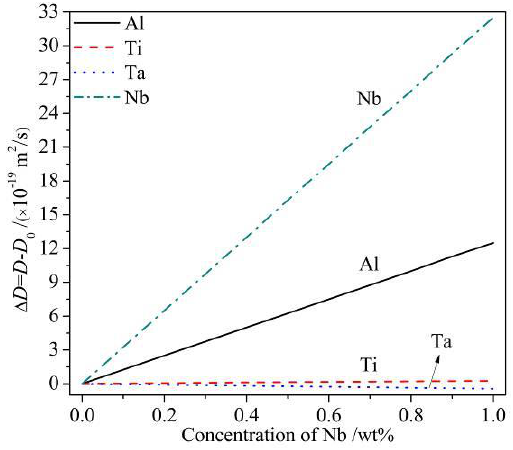
Figure 9. Diffusion coefficient increment of Al, Ti, Ta, Nb in γ matrix at 800 °C with different Nb concentration (calculated by DICTRA with the TTNI8 and MOBNI1 database).